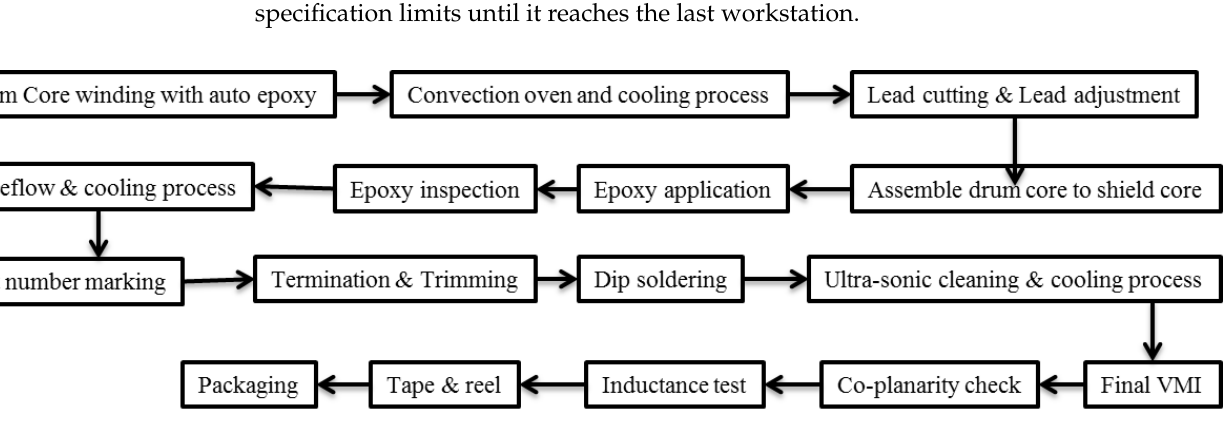
Figure 1. Workstations to produce the inductor component. The inductor component is examined and evaluated at all workstations in accordance with the requirements indicated in Table 1. There are 12 conditions with either a good or a bad